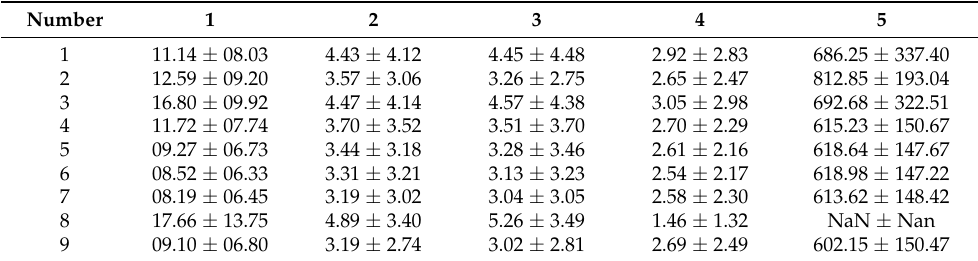
Table 1. Average reprojection error table of optimized images when n = 1, 2, 3, 4, and 5.